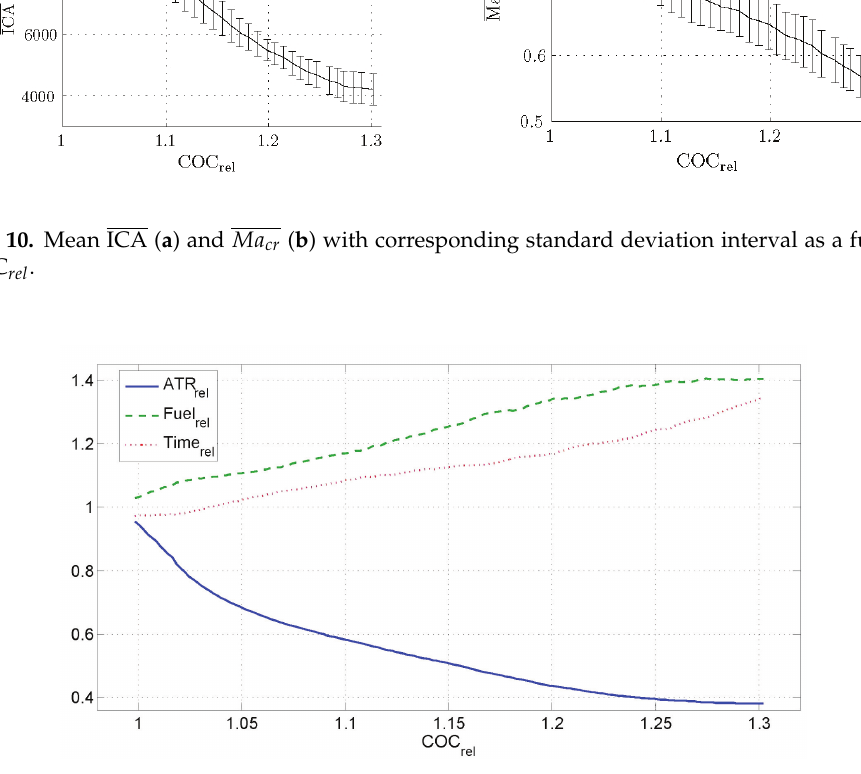
Figure 11. Flight frequency weighted fleet average mission time and mission fuel evolution as a function of COC rel (and ATR rel )